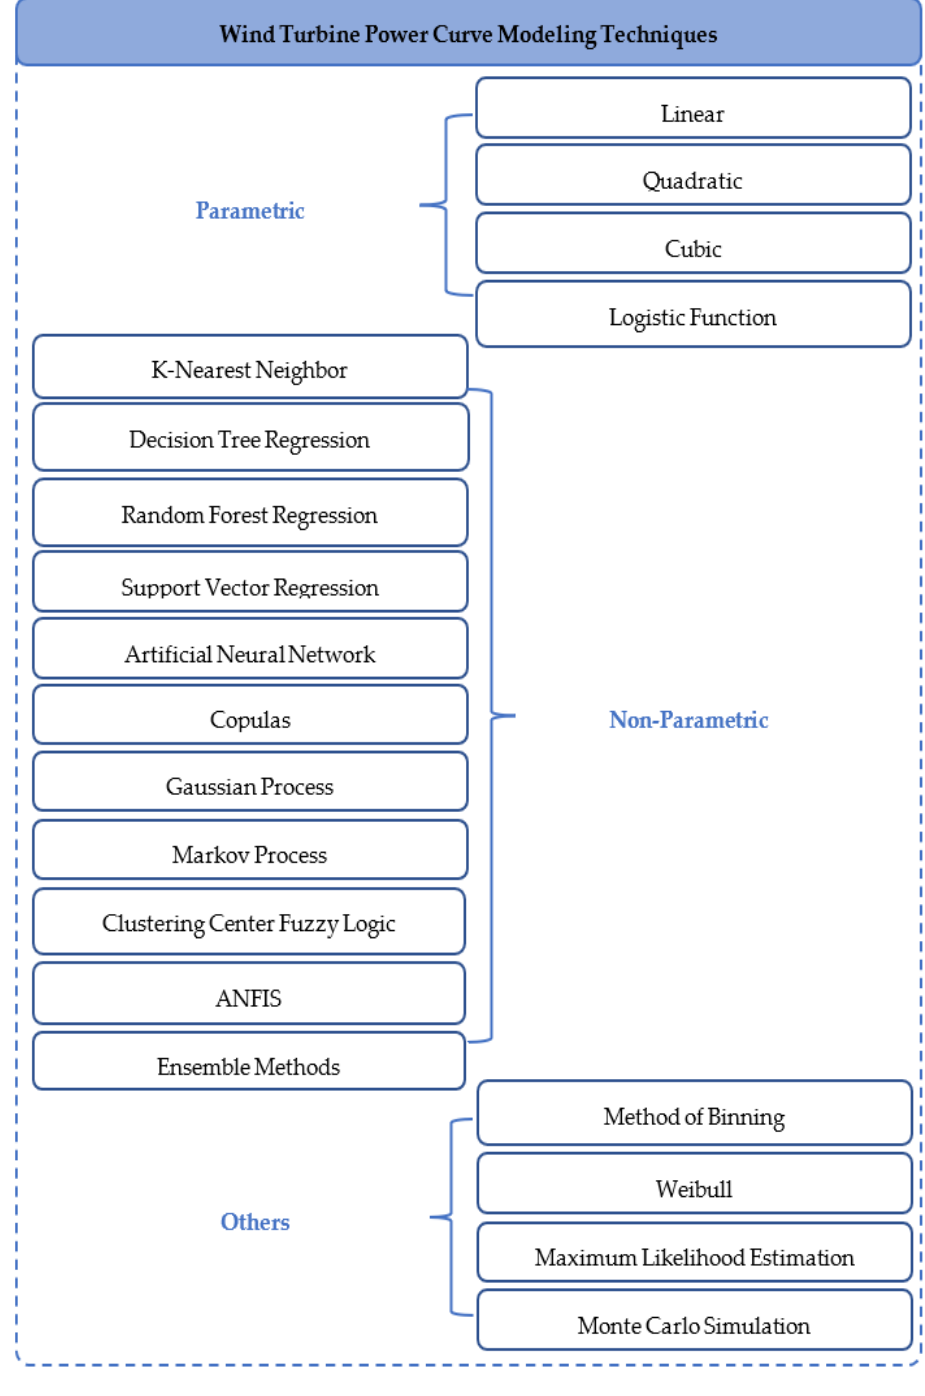
Figure 14. Reviewed power curve modeling techniques.